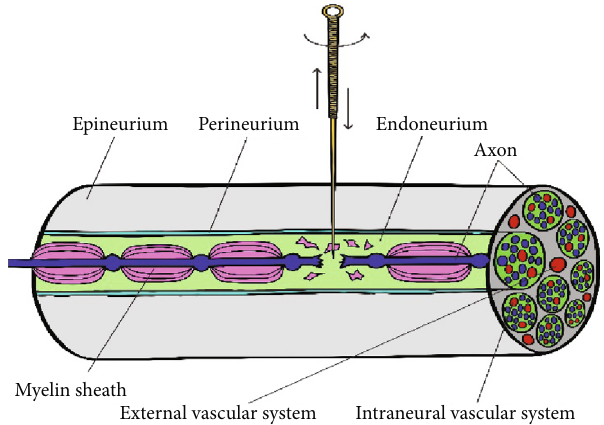
Figure 2: Traumatic demyelination and axonotmesis about peripheral